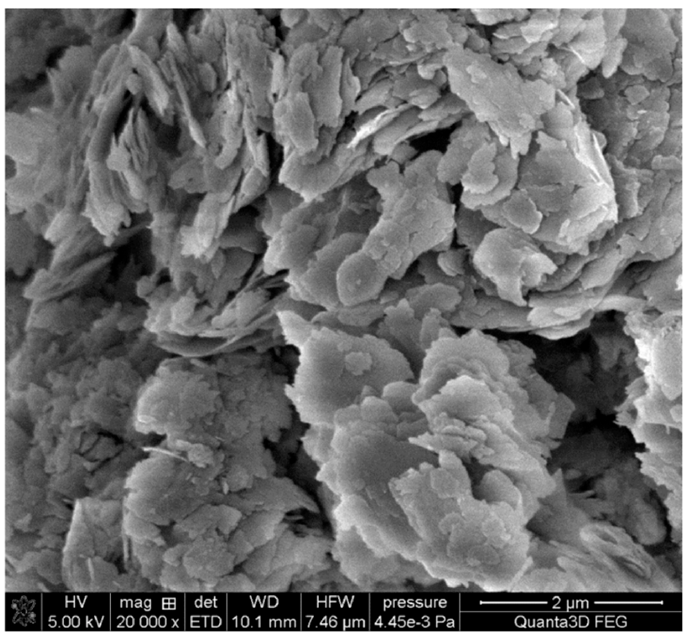
Figure 13. The SEM micrograph showing the morphology of the used glauconite, magnification ×10,000.